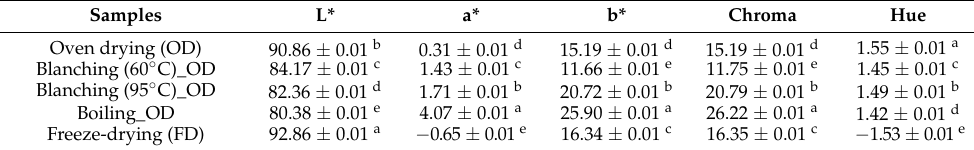
Table 2. Color parameters of potato flour from different treatments and drying conditions.